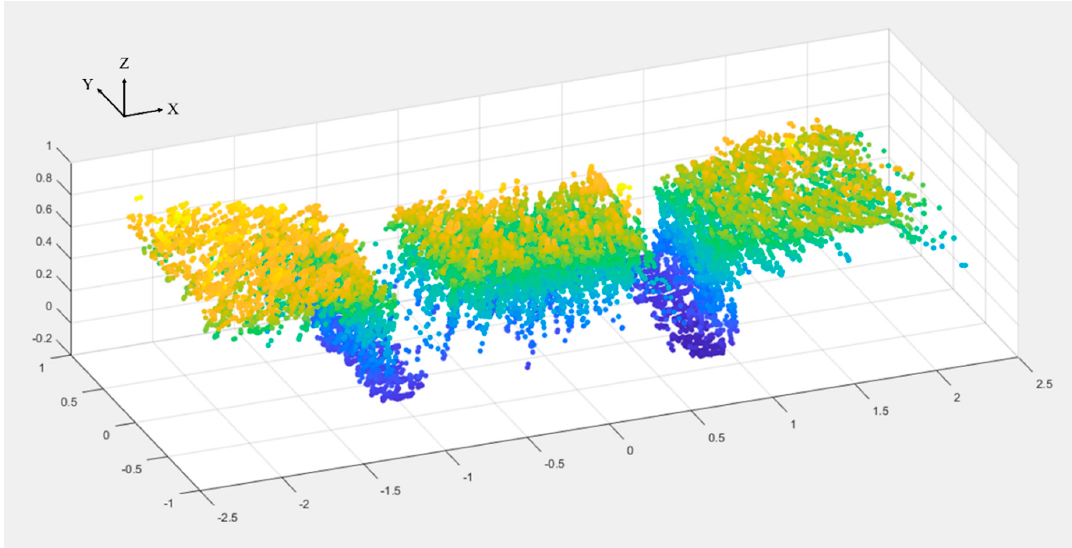
Figure 5. An example of raw LiDAR point cloud at each measurement.